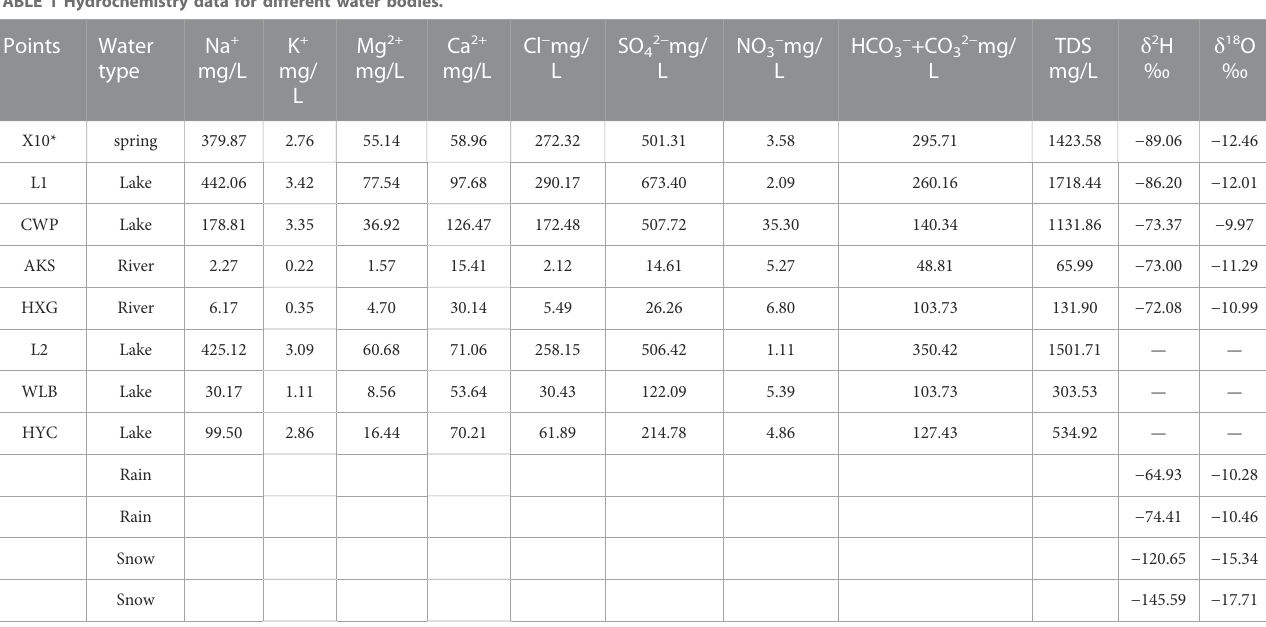
TABLE 1 Hydrochemistry data for different water bodies.